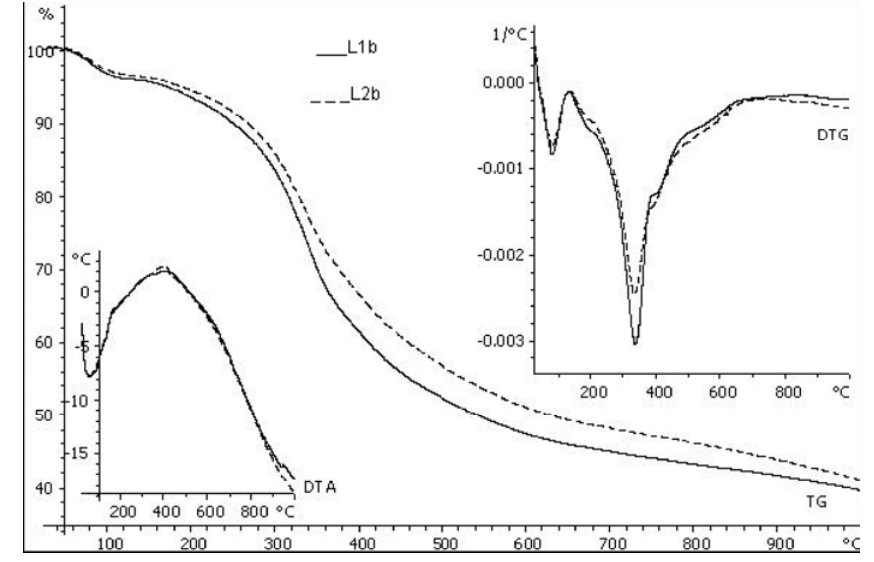
Fig. 5. Thermo-gravimetric (TG) weight loss curves of SE lignin. L1b – air-dry SE lignin